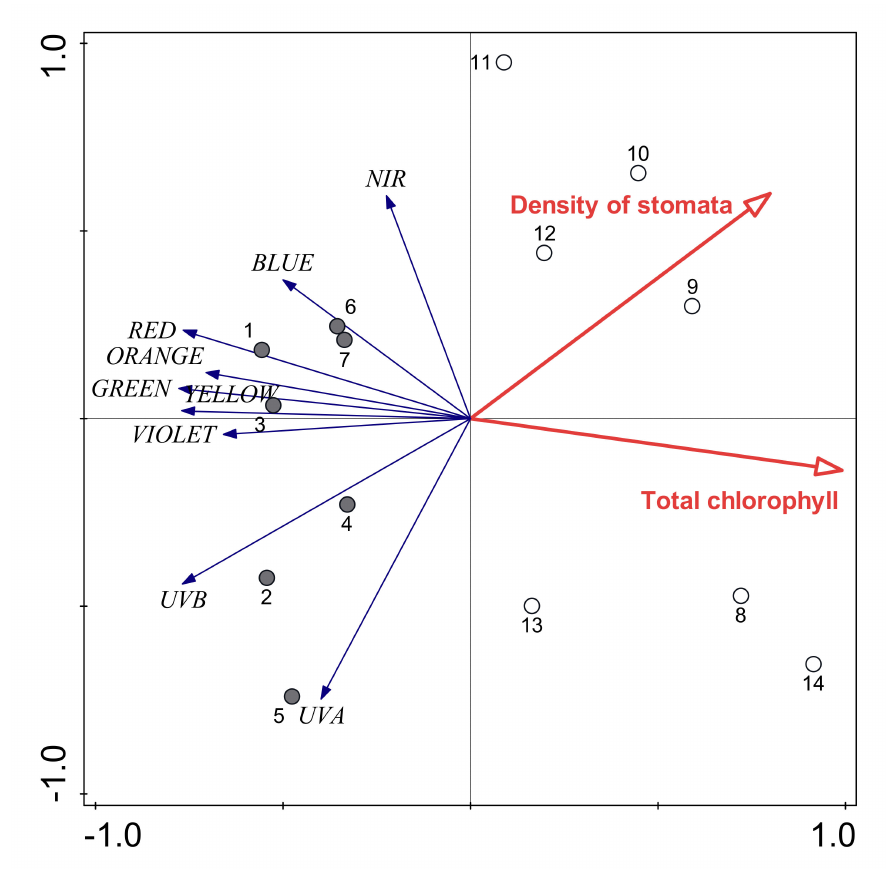
Figure 9. Redundancy analysis plot showing the strengths of the associations for total chlorophyll content and density of stomata with leaf reflectance spectra. Filled circles, control; open circles, water shortage.